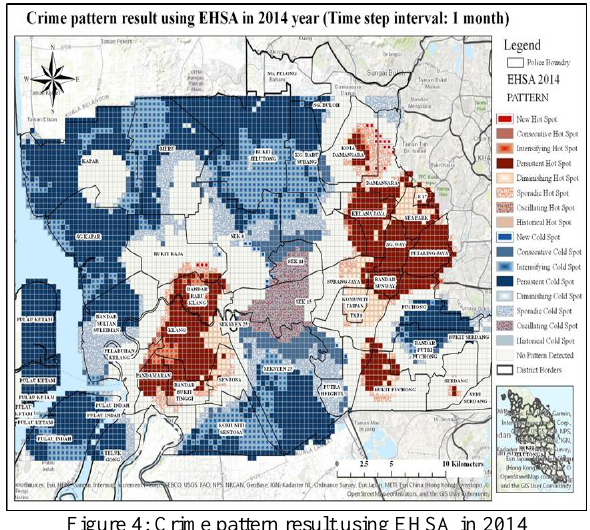
Figure 4: Crime pattern result using EHSA in 2014